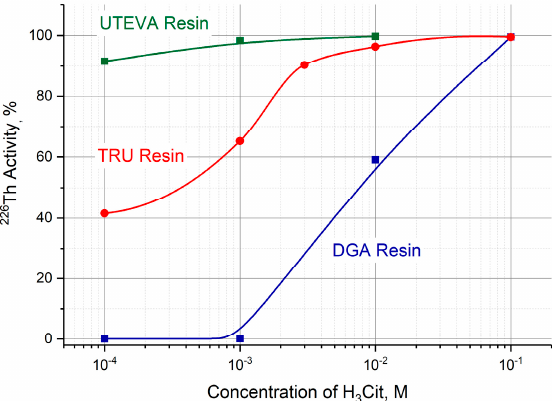
Figure 7. Efficiency of 226 Th desorption from DGA, TRU, and UTEVA resin columns as a function of citric acid concentration (pH 5.0).